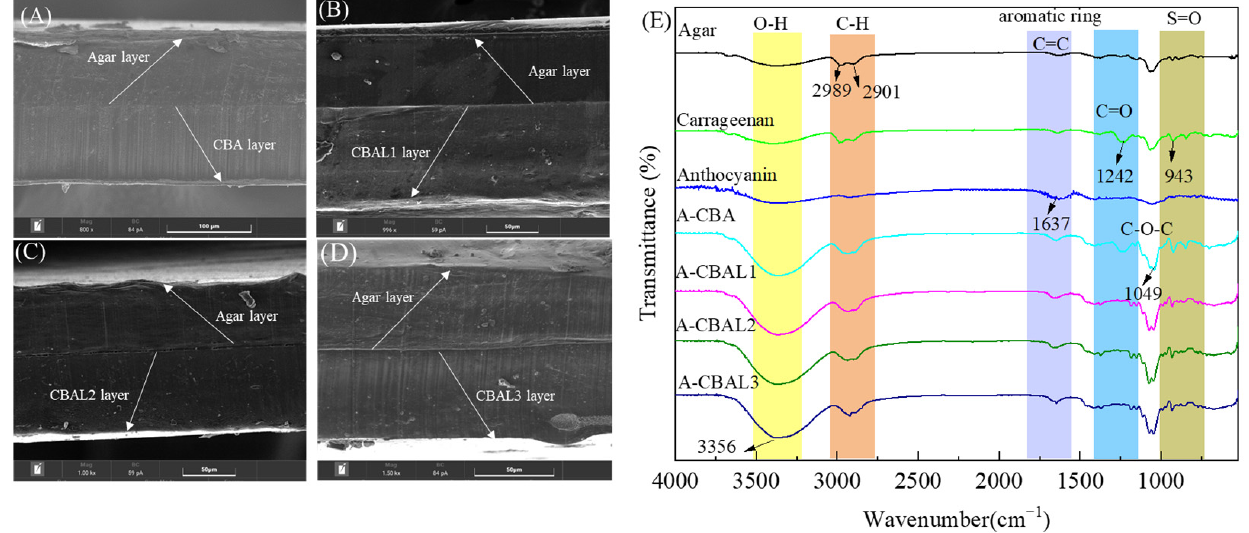
Figure 2. Cross-section SEM images of A-CBA ( A ), A-CBAL1 ( B ), A-CBAL2 ( C ), and A-CBAL3 films ( D ), and FTIR spectra ( E ) of colorimetric films.